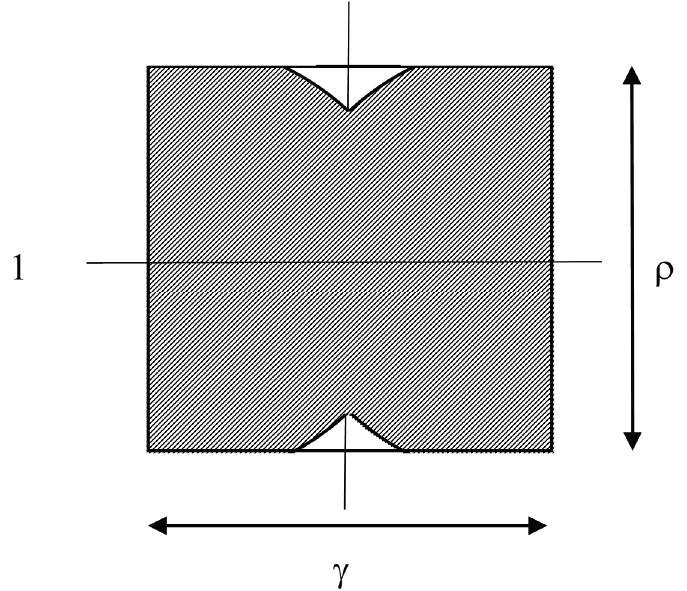
Figure 7. As for Figure 5, but with the swept area small compared to target size.